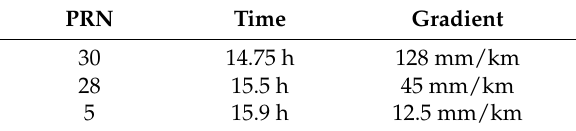
Figure 7. Maximum ionospheric gradient observed on 24 March 2017. ( a ) dual-frequency estimates of slant ionospheric delay; ( b ) ionospheric gradient; ( c ) elevation angles of PRN 28.